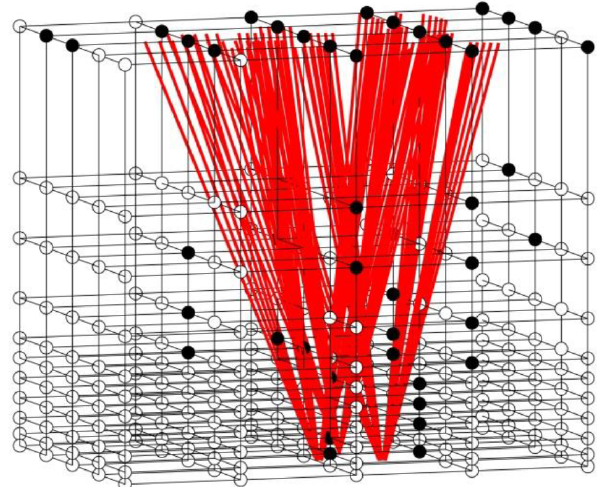
Figure 1. A three-station GNSS network from the Hong Kong Satellite Positioning Reference Station Network (SatRef) as an ex- ample for GNSS tomography – the rectangular cube is the tomo- graphic field adopted in current node parameterization approaches, the solid nodes are those near GNSS signals and the hollow nodes are those in the ESR.